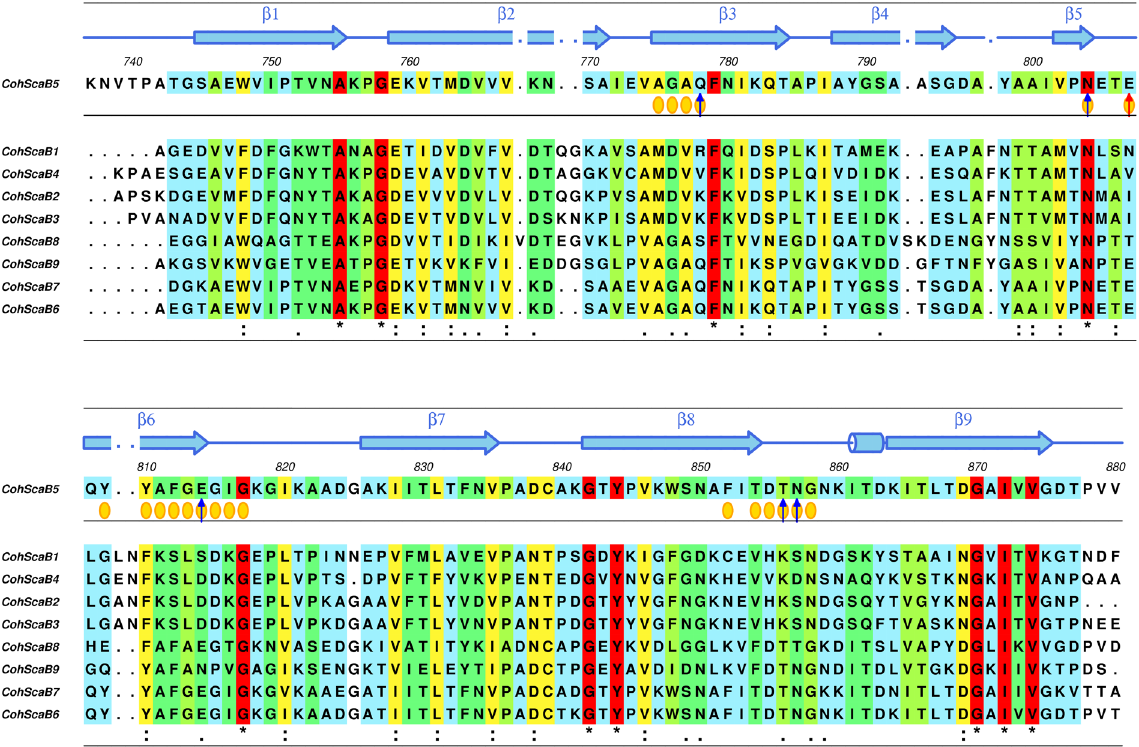
Figure 5. Multiple sequence alignment of R. flavefaciens ScaB cohesins 5 to 9. The primary sequence background is colored according to the ALSCRIPT Calcons convention, implemented in ALINE 51 : red, identical residues; orange to blue, lowering color-ramped scale of conservation. Above the alignment lies a cartoon representation of the secondary structure of Rf CohScaB5 (blue color) (Coh-Doc complex PDB codes: 5N5P). Residues involved in molecular interactions with the Doc partner are represented as follows: blue arrow for hydrogen bonds, red arrow for salt bridges and yellow circles for hydrophobic